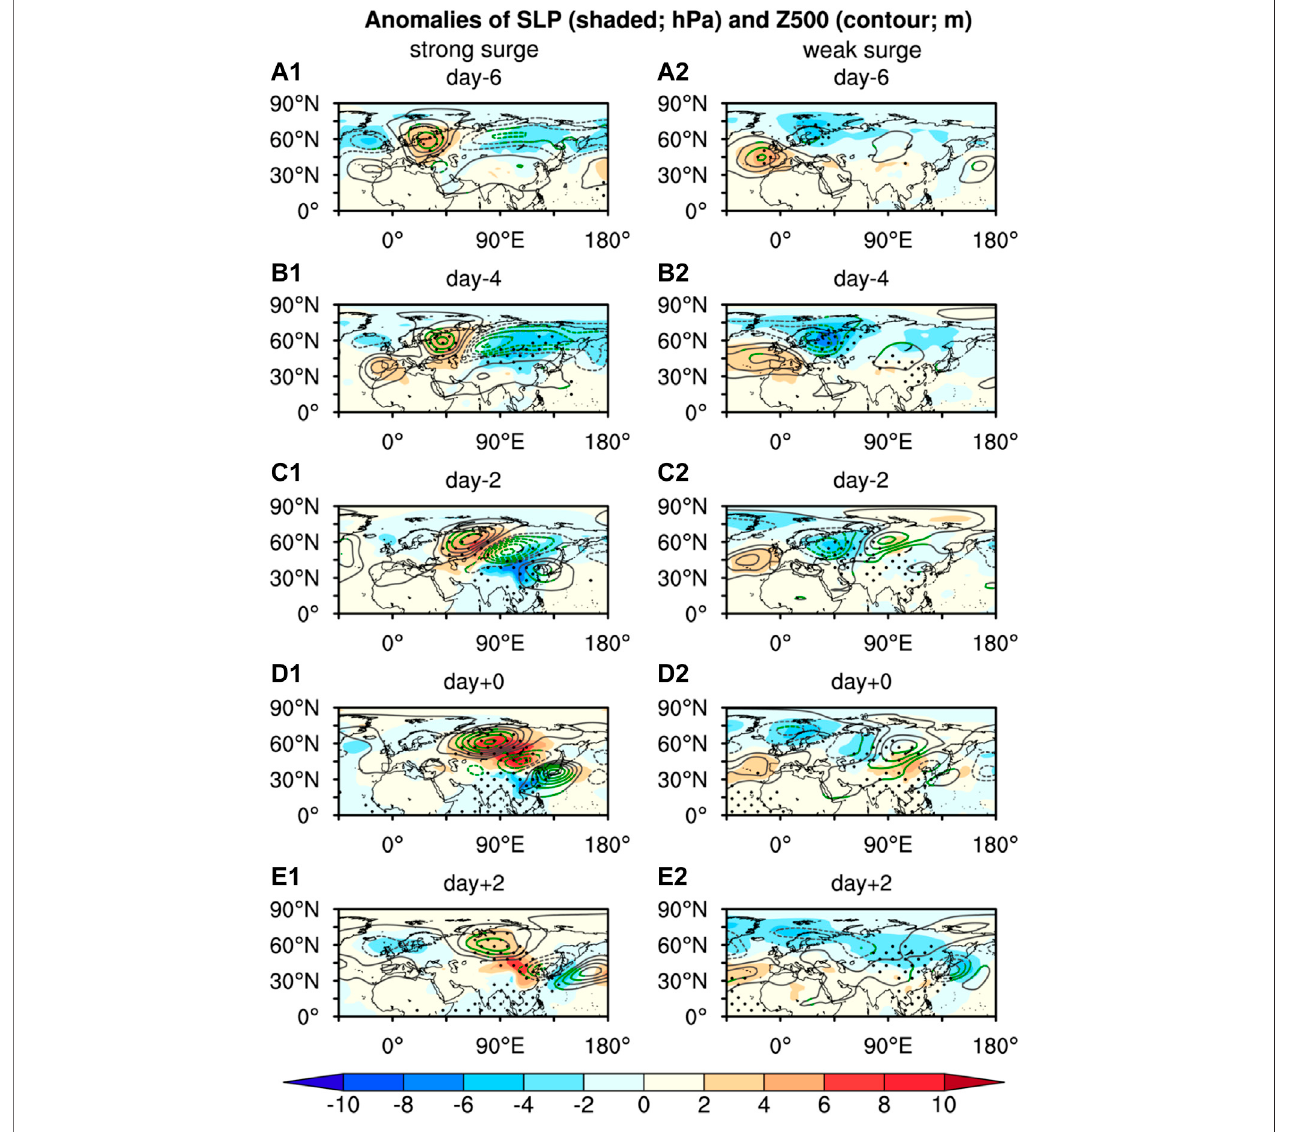
FIGURE 5 | Composite anomalies of sea level pressure (shaded; hPa) and 500-hPa geopotential height (contour interval: 15 m) from day-6 to day+2 of a (A1 – E1) strong and (A2 – E2) weakcoldsurge.DotsandGreencontoursindicatethe95%con fi denceintervalthatissigni fi cantlydifferentfromtheclimatologicalcoldsurgeusing the two tailed Student ’ s t -test. Note that the zero contour lines are omitted and positive/negative values are denoted by solid/dashed lines.